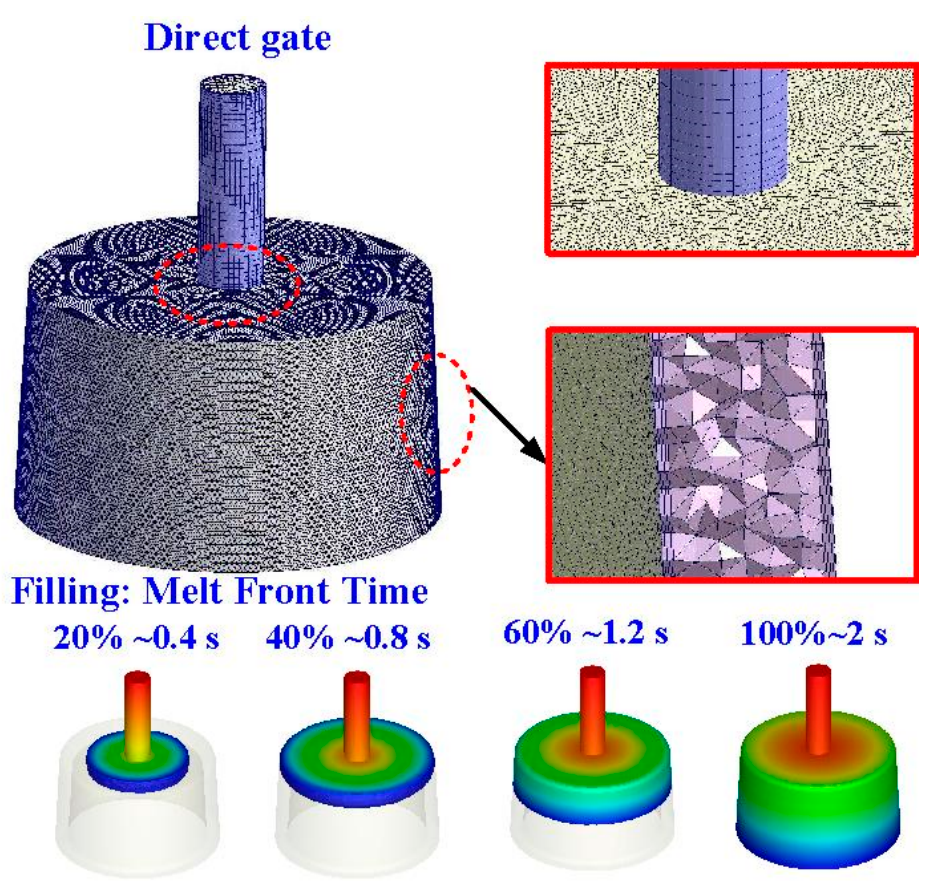
Figure 5. Mesh of the injection molded part and cooling channels.